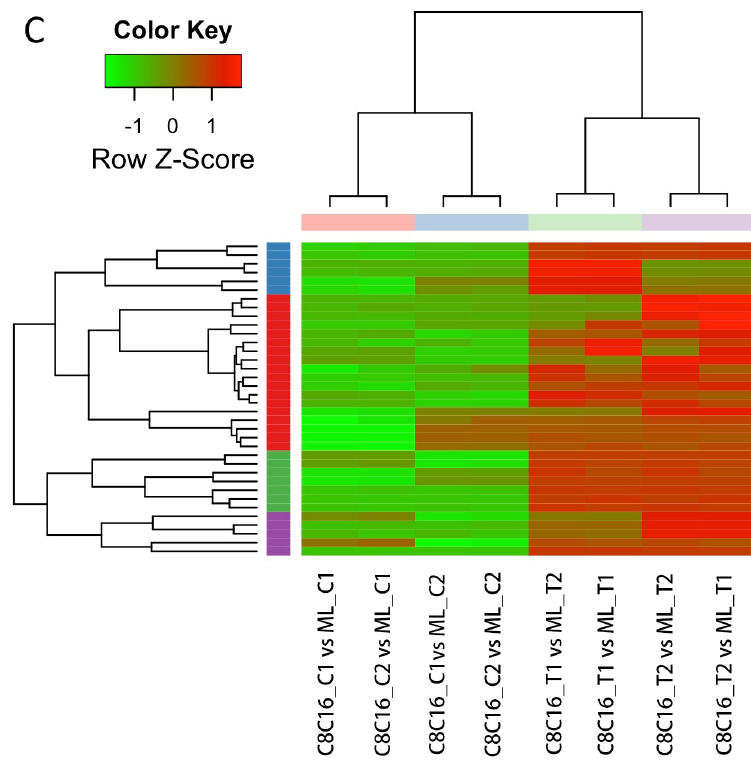
Figure 4. Heat map of hierarchical clustering for lncRNAs. ( A ). Heat map of 4273 predicted lncRNAs. Two biological replicates at the 8-16-cell stage or morula stage are presented together. ( B ) Heat map of 23 lncRNAs up-regulated (red) in the control group and down-regulated (green) in GSH-treated embryos. ( C ) Heat map of 36 lncRNAs down-regulated (green) in untreated embryos and up-regulated (red) in GSH-treated embryos.